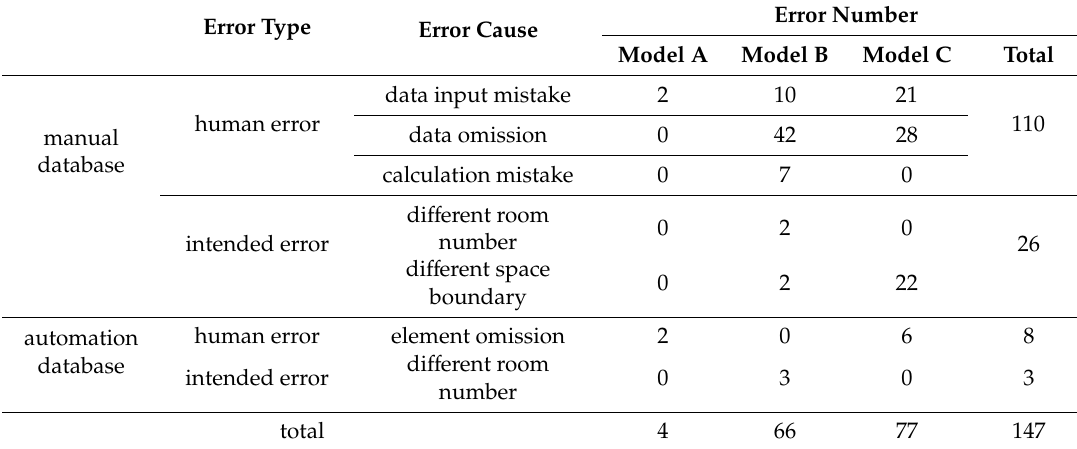
Table 7. Error cause and